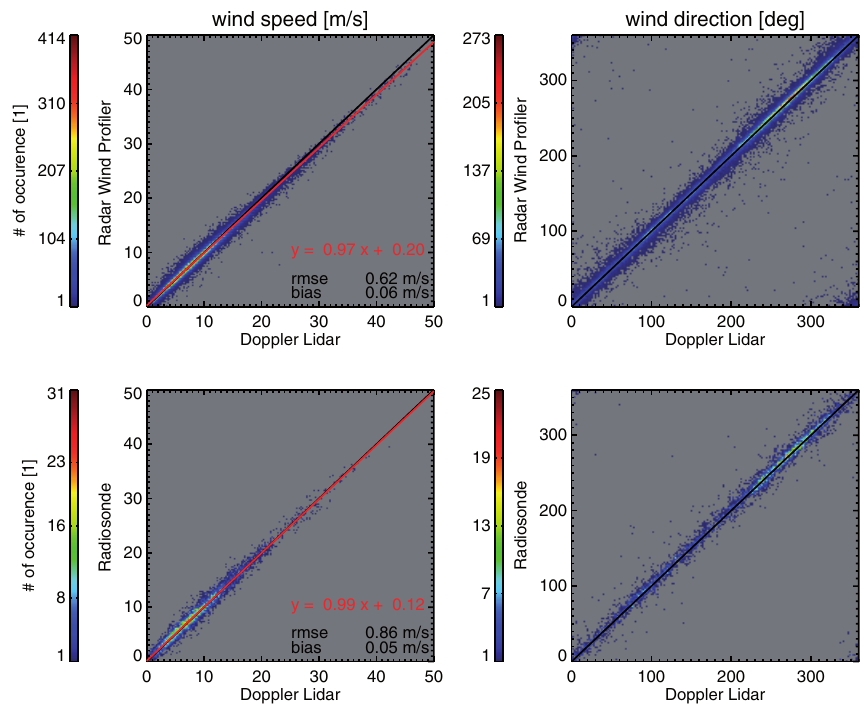
Figure 9. Top: scatter plots of 1-year 30min averaged horizontal wind speed and direction from the Doppler lidar and 482MHz radar wind profiler measurements (DLWR). Bottom: scatter plots of 1-year 30min averaged horizontal wind speed and direction from Doppler lidar and radiosonde (DLRS). Top and bottom: the scatter plots include measurements from all heights. The red line indicates the identity